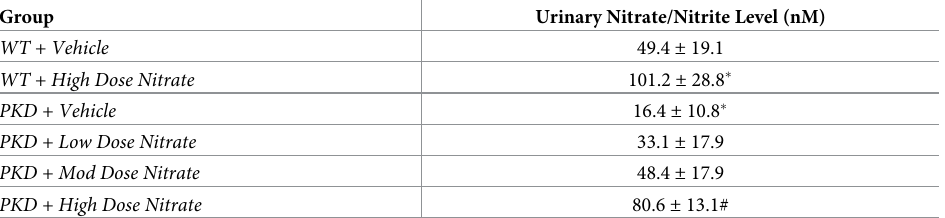
Table 2. Urinary nitrate/nitrite levels in wild-type (WT) and Pkd1 RC/RC (PKD) mice at 3 months of age treated with sodium chloride (vehicle) or sodium nitrate (low, 0.1 mmol/kg/day; moderate, 1 mmol/kg/day; high dose, 10 mmol/kg/day) for 2